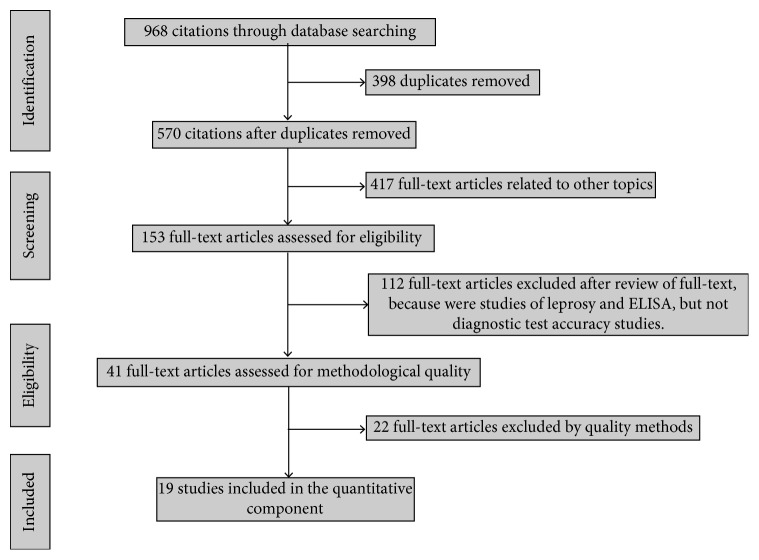
A flowchart of the steps performed in the systematic review and meta-analysis.